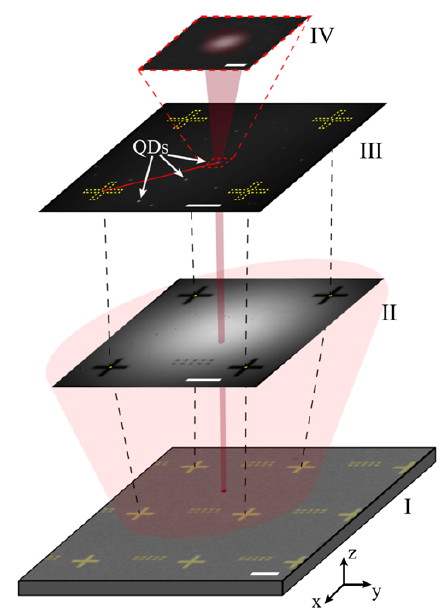
Figure 10. Prelocalization protocol for epitaxially grown QDs (real data shown) [49].